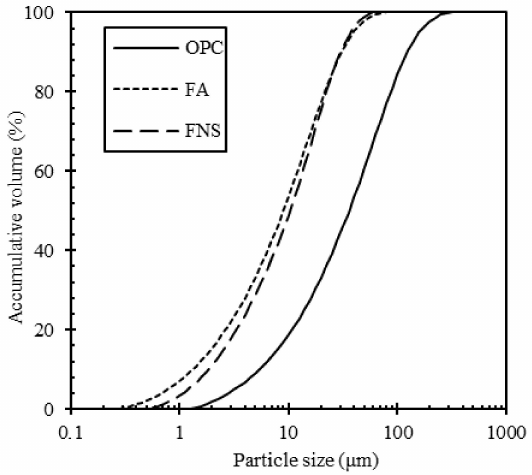
Figure 1. Particle size distribution of ordinary Portland cement (OPC), fly ash (FA), and ferronickel slag